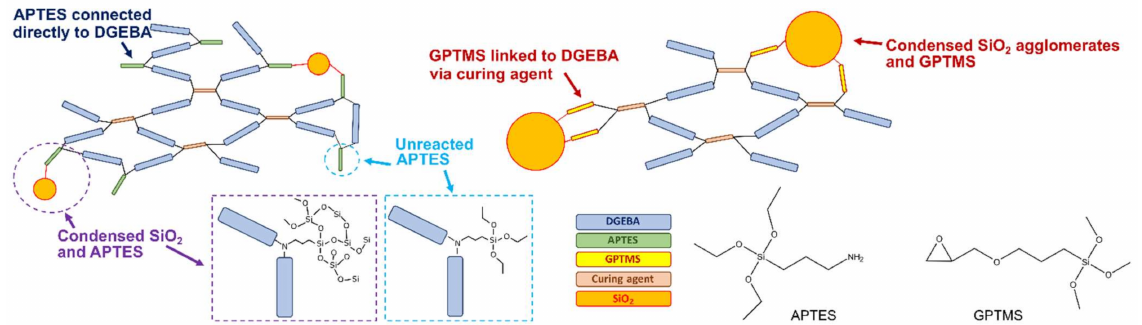
Figure 11. Schematic showing the structure of the two SCAs used and how they form a chemical link between the inorganic and organic components in the